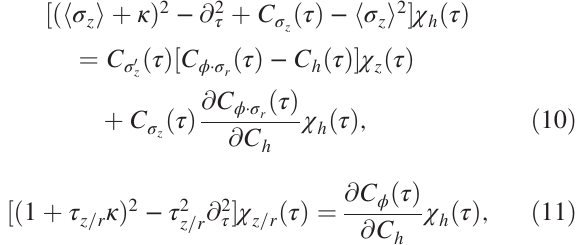
FIG. 3. Lyapunov spectra and dimensionality of the gated RNN. (a),(b) The first 50 ordered Lyapunov exponents for a gated RNN ( N ¼ 2000 ) as a function of varying (a) α and (b) α . z r The Lyapunov spectrum is calculated as described in Appendix D. (c) The Kaplan-Yorke dimensionality of the dynamics as a function of α . (d) The maximal Lyapunov exponent λ r max predicted by the DMFT [solving Eqs. (10) and (11); solid line] and obtained numerically using the QR method (circles; N ¼ 2000 and α 0 ). Note that the transition for α 20 is sharp; z ¼ r ¼ τ 2 . 0 also cf. Fig. 5(c). τ z ¼ r ¼